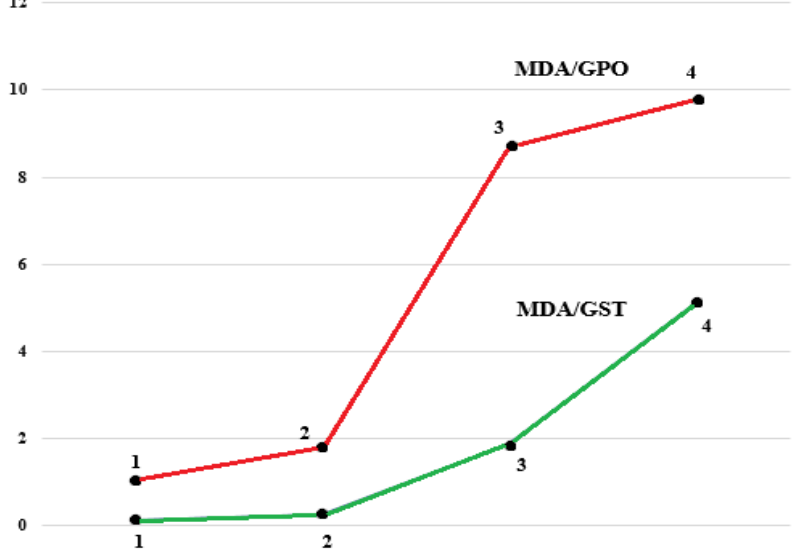
Figure 4. Concentration ratios of malonic dialdehyde to glutathione peroxidase and malonic dialde- hyde to glutathione S-transferase in the blood plasma of patients with atrophic gastritis and gastric cancer. 1—Group A; 2—Group B; 3—Group C; 4—Group D. The significance of differences